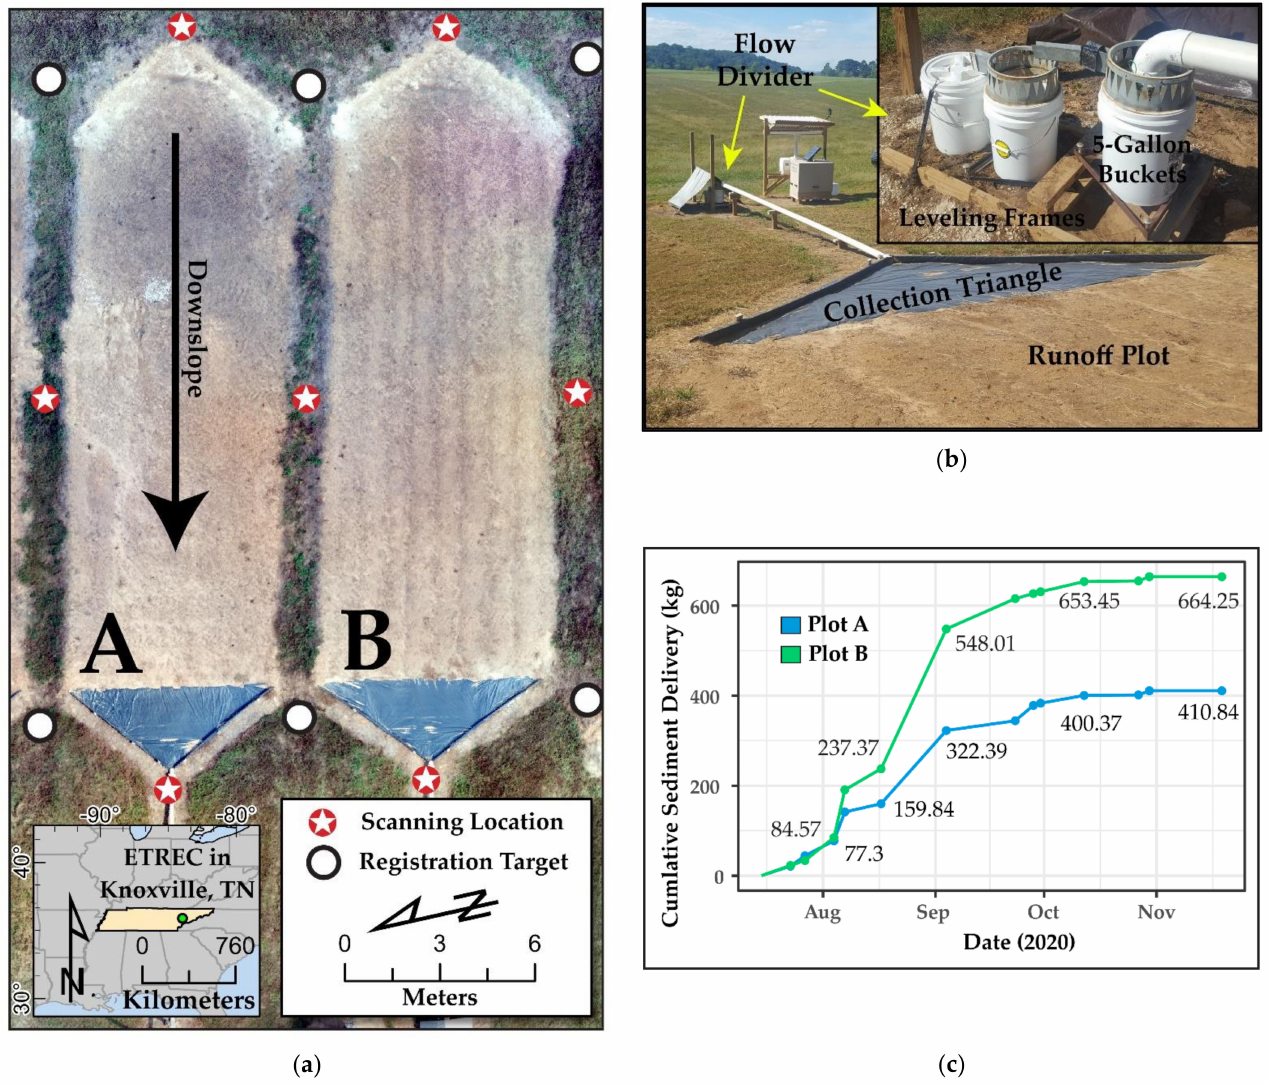
Figure 4. ( a ) East Tennessee Research and Education Center (ETREC) study site with plots A and B used in the case study. ( b ) Photograph showing the flow divider system on plot B. ( c ) Cumulative sediment delivery data sampled from the field